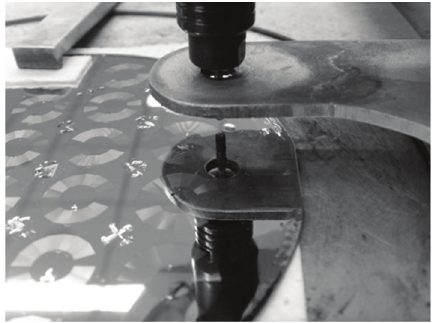
Figure 5: Air core created by abrasion drilling process.